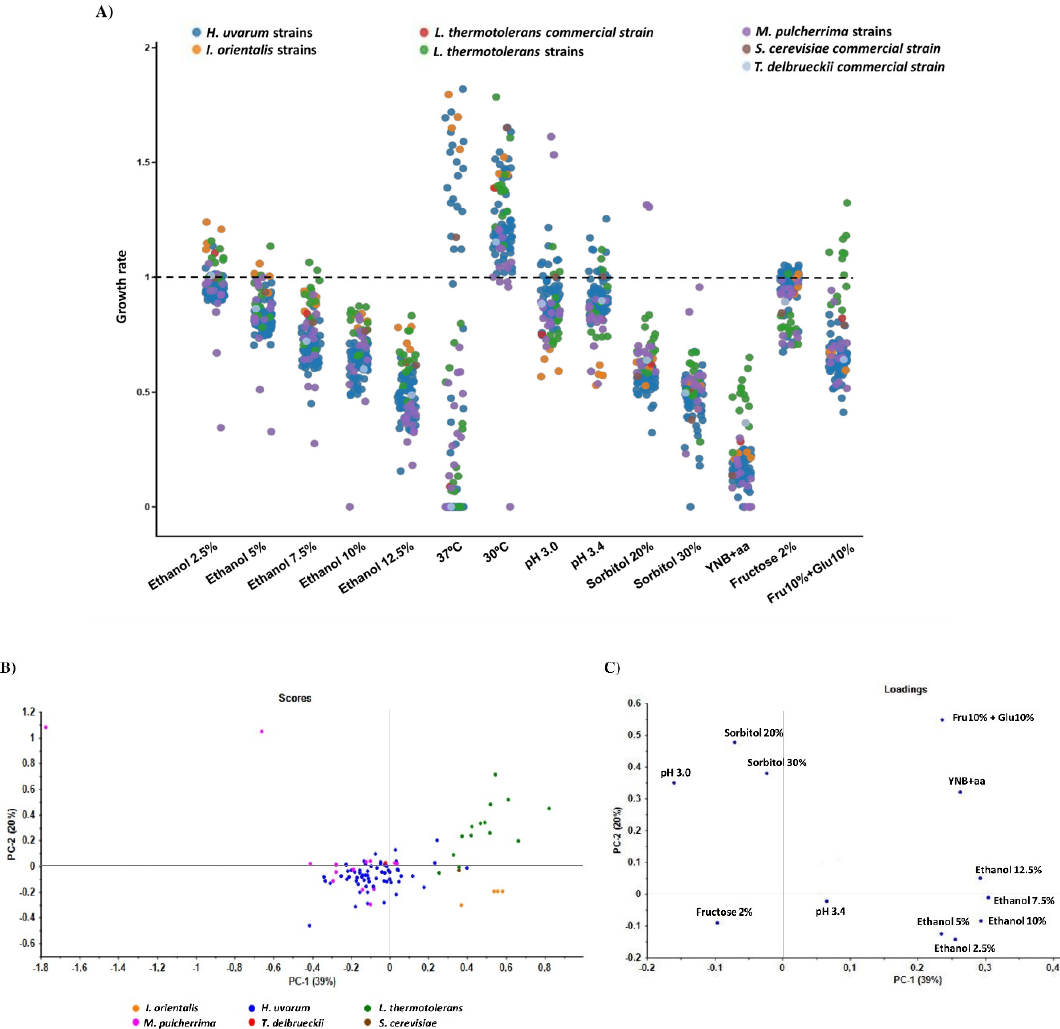
Figure 2. Phenotypic screening of selected non- Saccharomyces species isolated from Port wine must samples on stress conditions associated with alcoholic fermentation. ( A ) Growth performance of selected non- Saccharomyces strains on YEPD culture plates supplemented with stress conditions associated with alcoholic fermentation. Stress conditions include different concentrations of ethanol, temperatures (37 °C and 30 °C), acidic pH (3.0 and 3.4), osmotic stress (Sorbitol 20% and 30%), different nitrogen source (YNB + essential amino acids), and different carbon sources (Fructose 2% and Fructose 10% + Glucose 10%). For the assay 92 non- Saccharomyces isolated strains were selected, and as reference controls two commercial non- Saccharomyces , respectively, L. thermotolerans and T. delbrueckii , and the commercial S. cerevisiae . Results represent the mean value of the colony size area quantified in the plates supplemented with stress conditions, relative to that quantified in the control plates (no stress). Mean values were obtained for biological triplicates from three independent growth experiments. The PCA score plot ( B ) and loading plot ( C ) in terms of Principal Component 1 (PC 1, x-axis) and Principal Component 2 (PC 2, y-axis) for the selected I. orientalis , H. uvarum , L. thermotolerans , M. pulcherrima , and the commercial strains. Singular Value Decomposition (SVD) with imputation was used to calculate principal components.